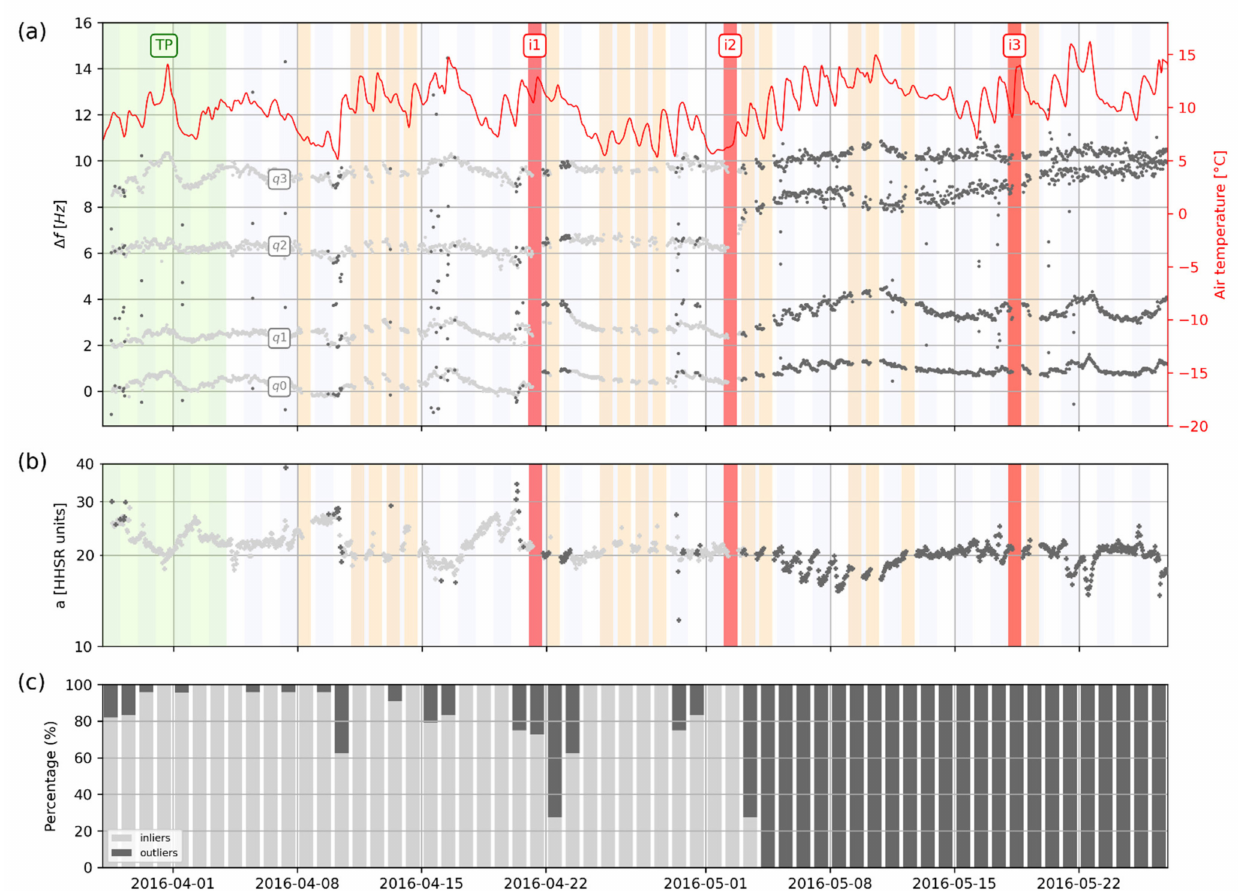
Figure 13. Novelty detection results performed on dataset D1 (HHSR ( q 0 , q 1 , q 3 , q 5 , and a HHSR ( q 0 )) along with air temperature time series). Peak frequencies q 0 , q 1 , q 3 , q 5 shown from bottom to top in ( a ). They have been arbitrarily shifted for the sake of easier comparison. HHSR amplitude a HHSR ( q 0 ) is shown in ( b ). Inlier data are shown in dark gray while outliers are shown in light grey. Training period (TP) at the beginning is underlined in green. Air temperature on-site is shown as red curve in ( a ). Reinforcement work stages are shown in the background: drilling days (light orange) and grout injection (red). ( c ) Respective percentage of inlier and outlier data in the detection